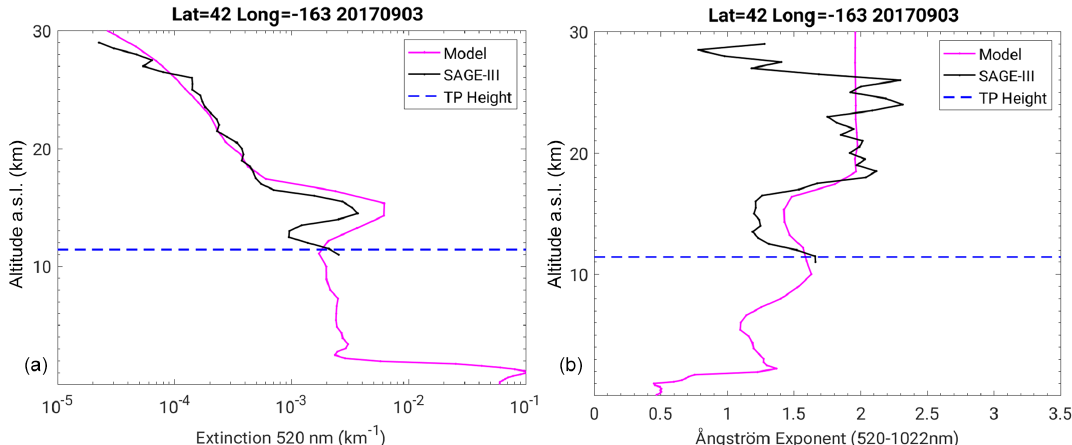
Figure 2. Calibration of model aerosol size distribution. (a) Aerosol extinction profiles retrieved from SAGE-III instrument and simu- lated by the GEOS model at 520nm for an overpass of SAGE-III/ISS over a pyroCb-emitted stratospheric smoke layer at about 14km on 3 September 2017. (b) The corresponding Ångström exponent (AE) profiles for SAGE-III and GEOS were calculated based on extinctions at 520–1020nm wavelength pair. Here, the GEOS model assumption of BrC particle size distribution (or pyroCb BrC optics) is calibrated to match the AE obtained from